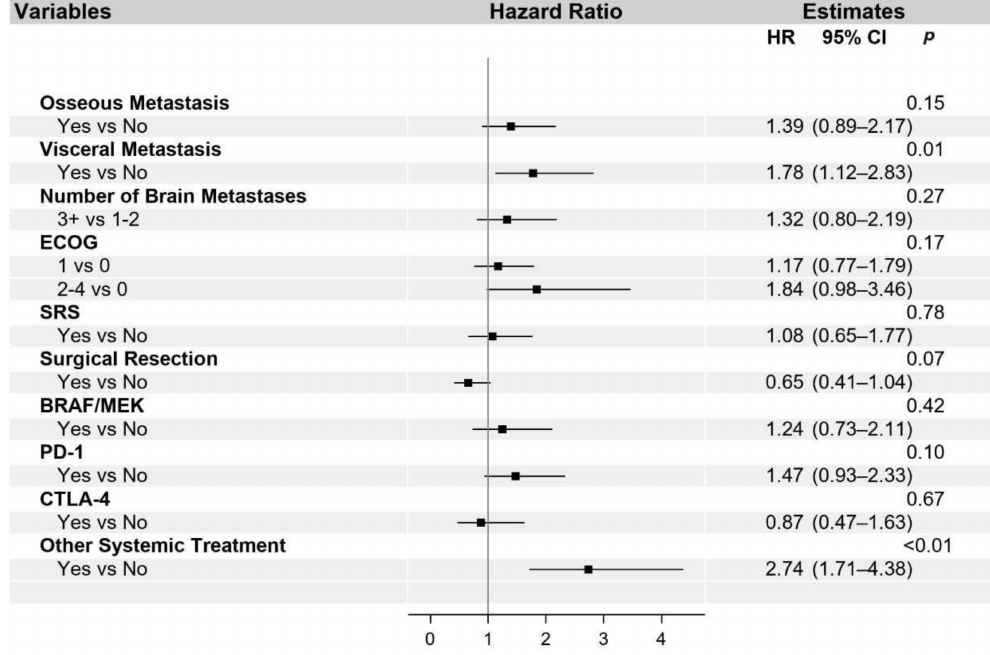
Figure 3. Multivariable analysis of progression-free survival. Abbreviated variable names include Eastern Cooperative Oncology Group performance status (ECOG), stereotactic radiosurgery (SRS), whole-brain radiation therapy (WBRT), and metastasis